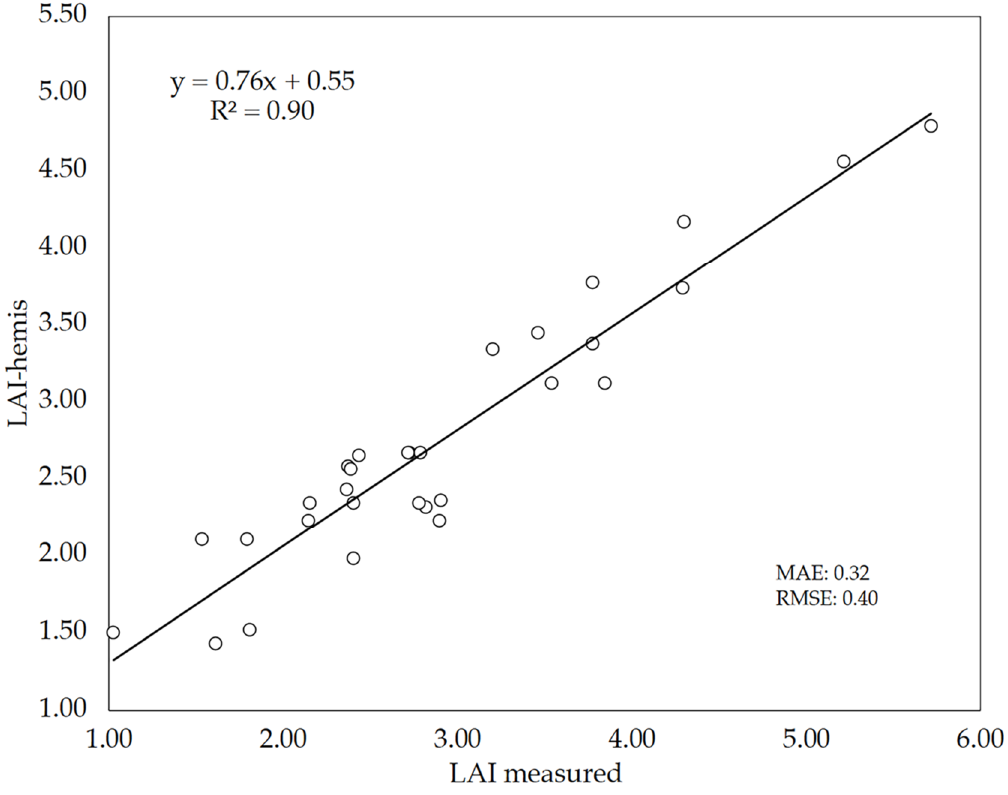
Figure 8. Relationship between measured LAI (direct method) and LAI estimated by bottom-up hemispherical images (LAI-hemis). The number of plots analyzed was n = 30. The straight line represents the best-fit linear regression ( p < 0.001).